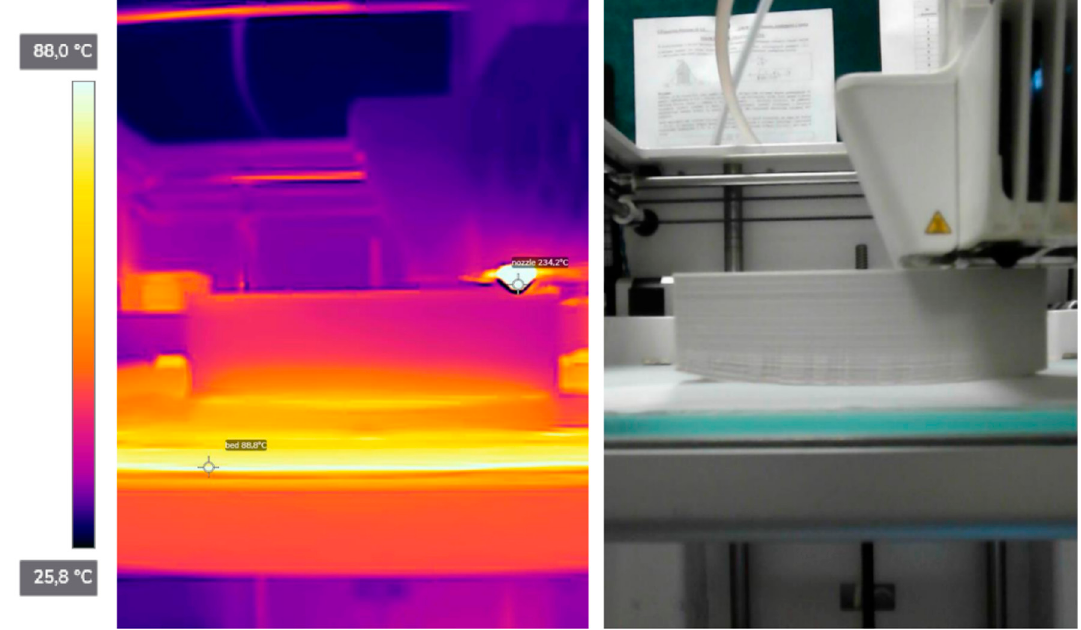
Figure 15 . ( Left ): thermal imaging with marked points: nozzle and bed. ( Right ) : image taken simultaneously in the visible band .